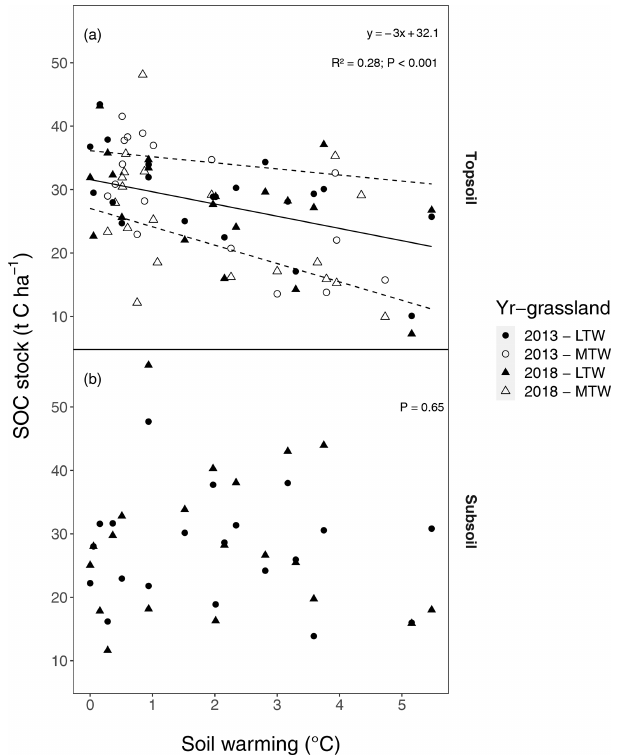
Figure B1. Uncorrected soil organic carbon (SOC) stock in relation to soil warming, (a) in the topsoil (0–10cm) and (b) in the sub- soil (10–30cm). All soil samples were taken in July 2013 or July 2018. The regression for medium-term warmed (MTW) and long- term warmed (LTW) grassland (in topsoil) for both 2013 and 2018 was combined, since neither a soil temperature–warming duration interaction effect nor a main effect for warming duration was found. Soil warming is expressed relative to ambient soil temperature (both at 10cm depth). In topsoil, a linear relation was observed, while no significant effect was present in subsoil. The 95% confidence bounds are shown around the topsoil regression slope. ( n = 78 and n = 40 for topsoil and subsoil respectively.)